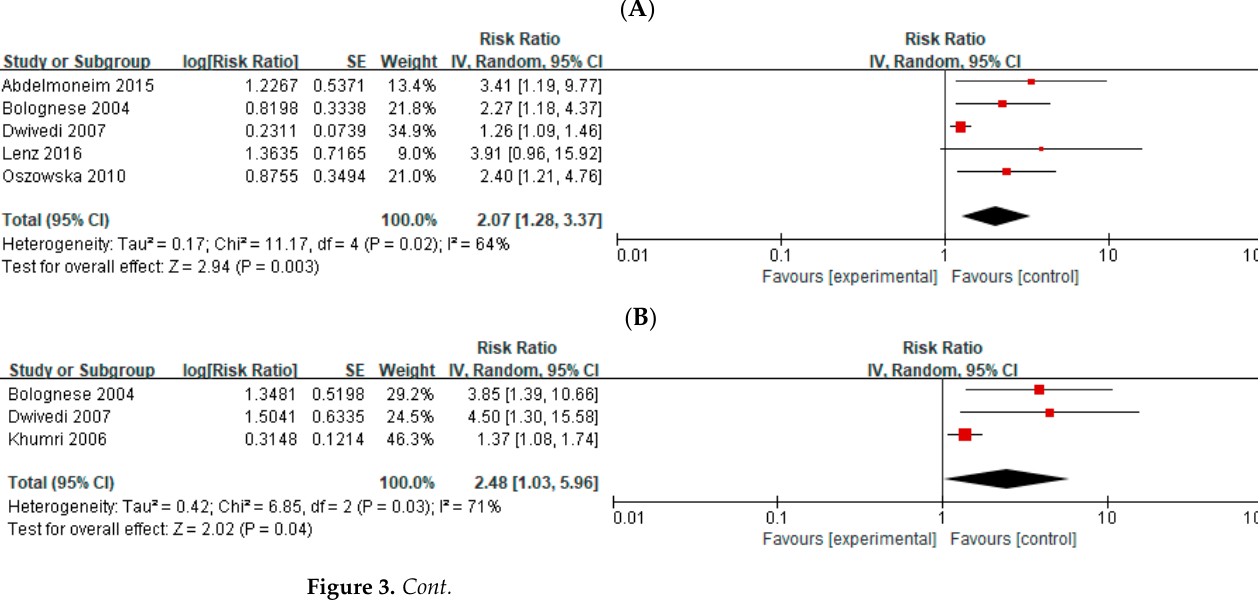
Figure 2. Forest plots of ( A ) pooled sensitivities, ( B ) specificities, and ( C ) summary receiver–operating characteristic curve ( C ) of myocardial contrast echocardiography to predict major adverse cardiac events during follow-up visits [13,14,16,17].